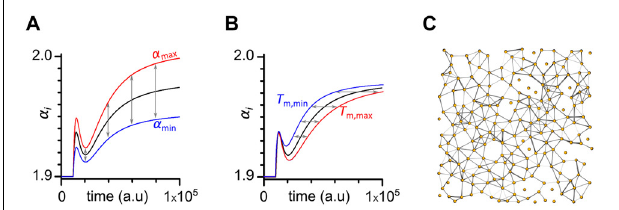
FIGURE 3 | A schematic representation of all three types of heterogeneities in the model. (A) electrical excitability (cid:49) α i , (B) beta cell metabolism T m , i , (C) electrical coupling g i . Widths of connections reflect the coupling